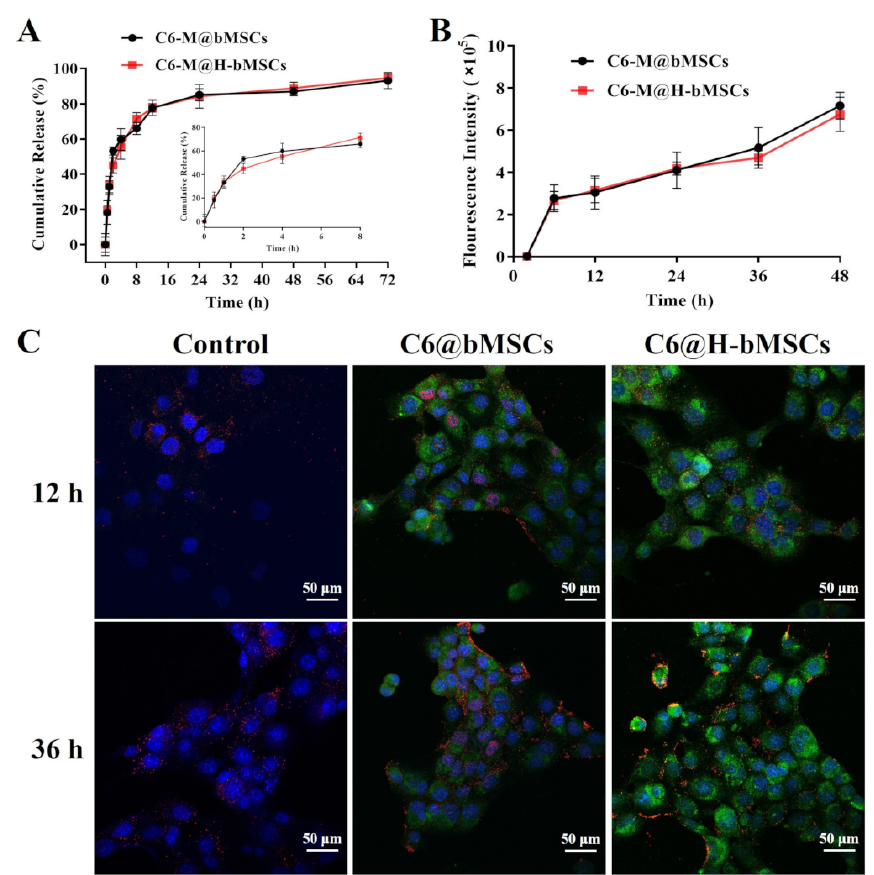
Figure 4. The drug delivery behavior in vitro. The drug release behavior of the complexes ( A ); the cellular uptake of 4T1 cells from bMSCs or H-bMSCs ( B ); the images of drug delivery from bMSCs or H-bMSCs to 4T1 cells ( C ), red fluorescence indicates BrdU labeled 4T1 cells, blue fluorescence indicates DAPI and green fluorescence indicates C6 or